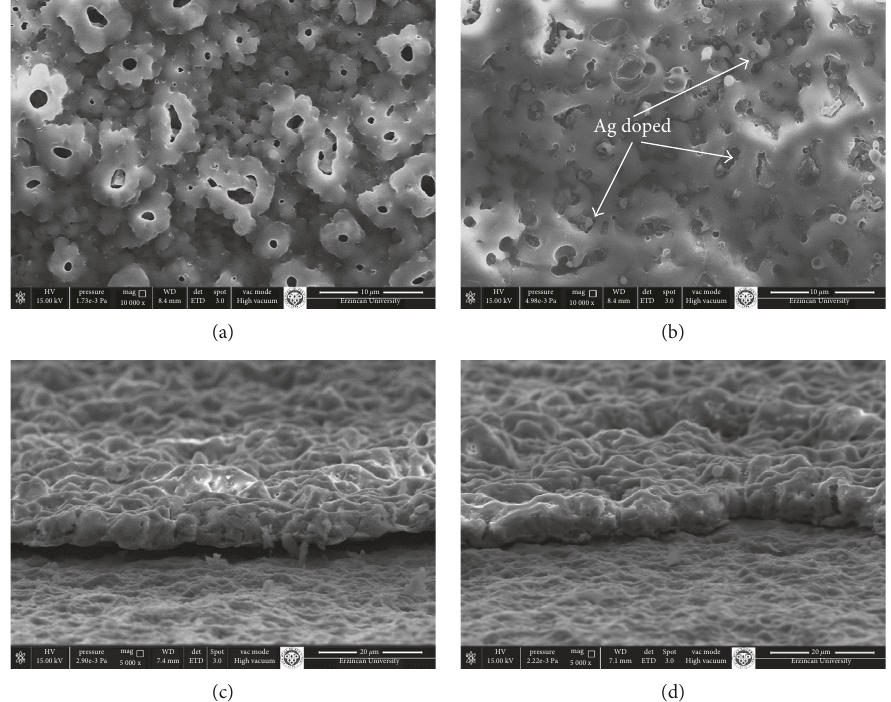
Figure 1: SEM images after MAO. Surface images of samples coated in (a) electrolyte A and (b) electrolyte B. Cross-sectional images of samples coated in (c) electrolyte A and (d) electrolyte